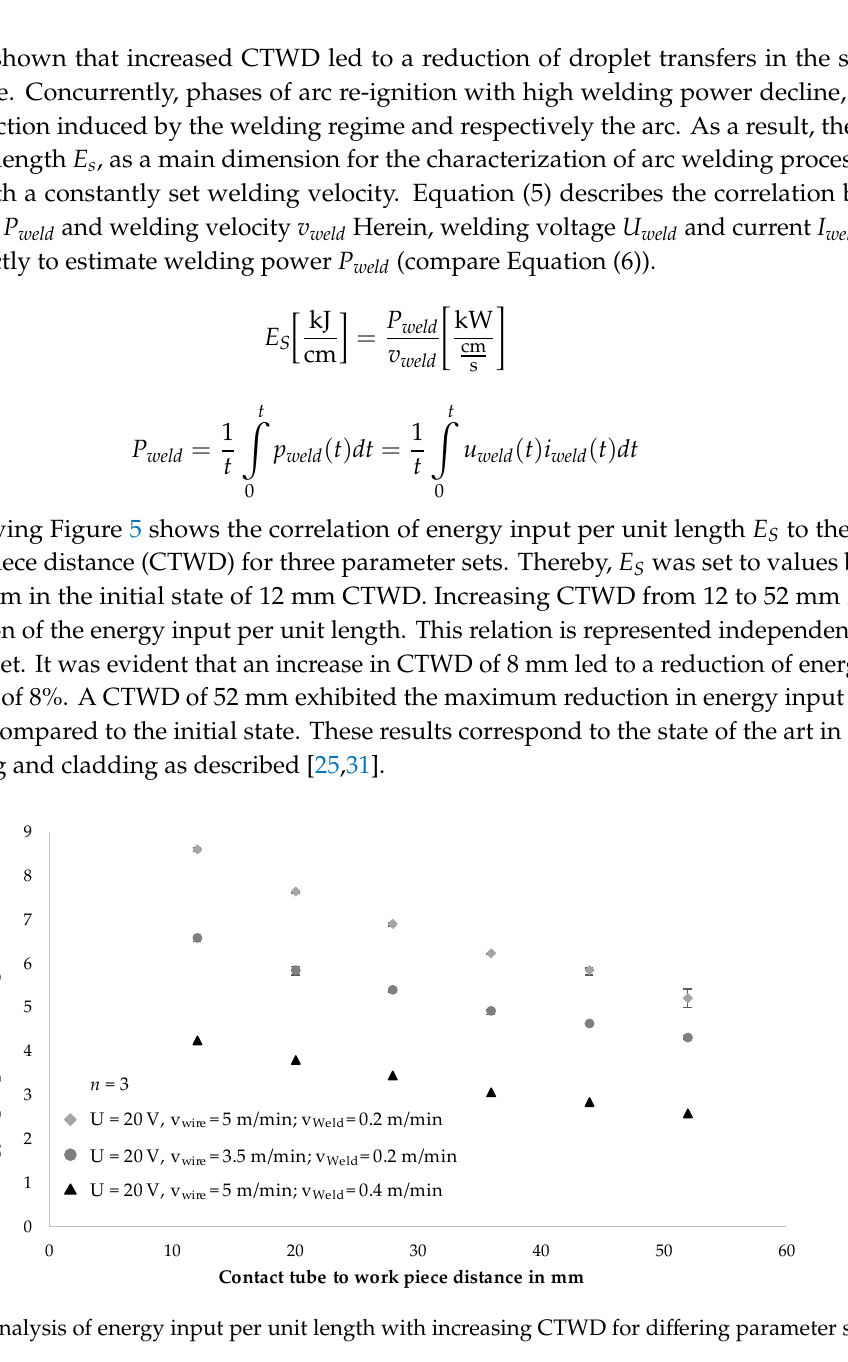
Figure 5. Analysis of energy input per unit length with increasing CTWD for differing parameter sets.